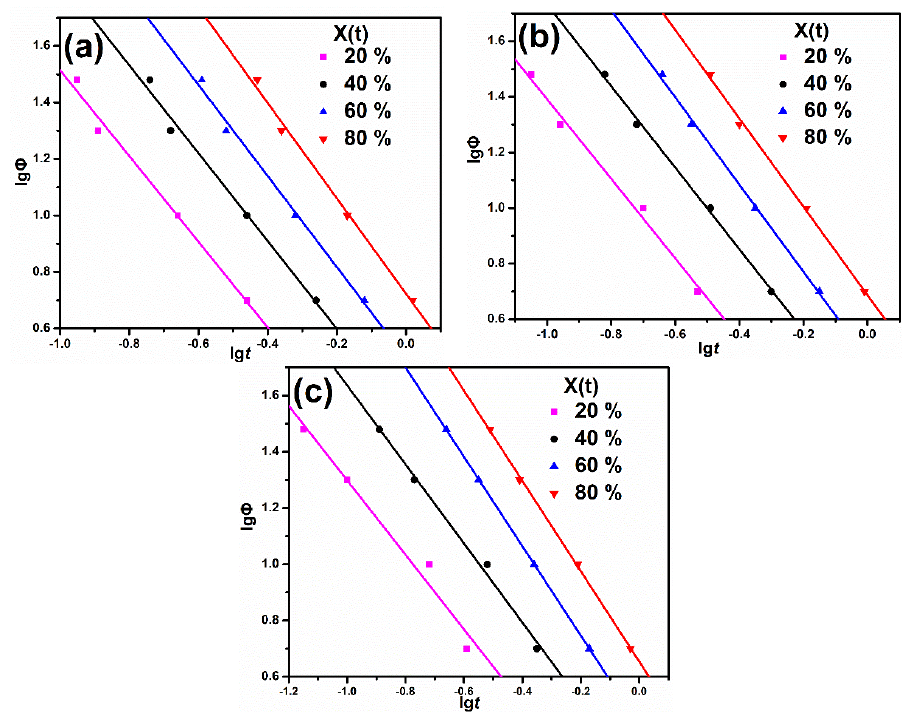
Figure 5. Plots of lg  versus lg t for PP and its composites at different relative degrees of crystallinity. ( a ) PP, ( b ) PP/MBw, and ( c ) PP/BAE-MBw. ( a ) PP, ( b ) PP / MBw, and ( c ) PP /